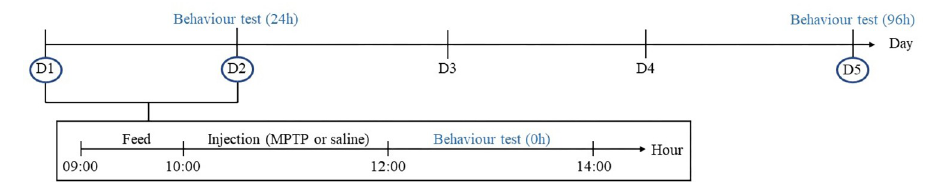
Fig 1. Timeline of the experimental procedure. MPTP injection was done on Day 1. Swimming behaviour tests were done on the 0 th , 24 th , and 96 th hour after